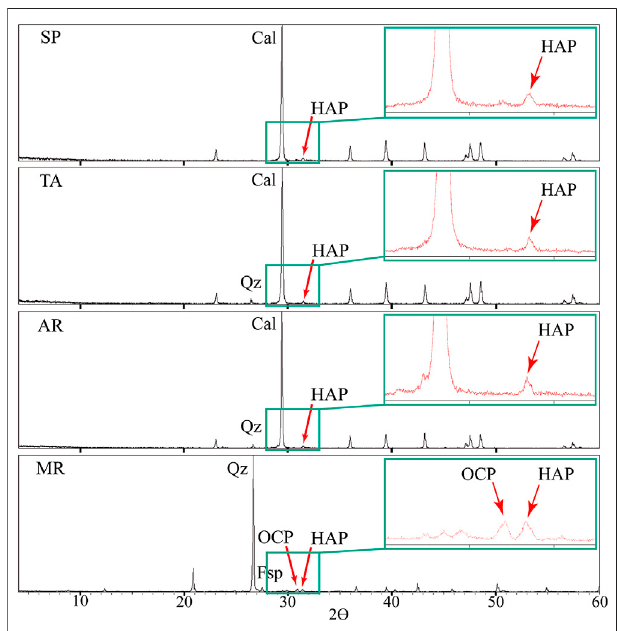
FIGURE 2 | Diffractograms for the treated samples of Calcarenita de Santa Pudia (SP), Travertino Amarillo (TA), Arenisca Ronda (AR) and Molinaza Roja (MR). Legend: Cal, calcite; Qz, quartz; Fsp, feldspar; HAP, hydroxyapatite; OCP, octacalcium phosphate. The value of the 2 θ angle is indicated on the X